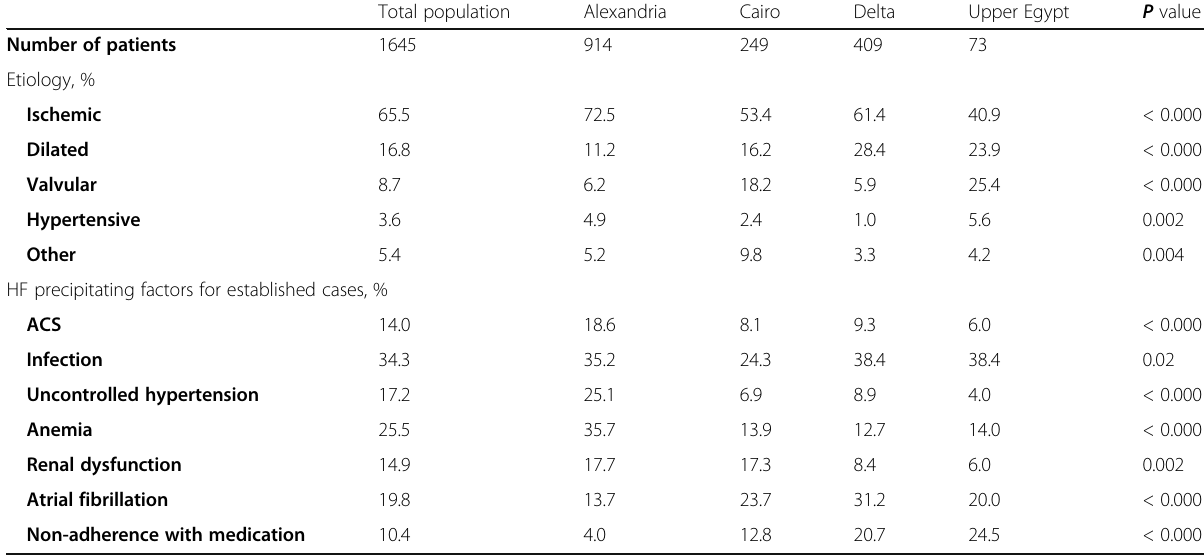
Table 2 Etiology and heart failure precipitating factors